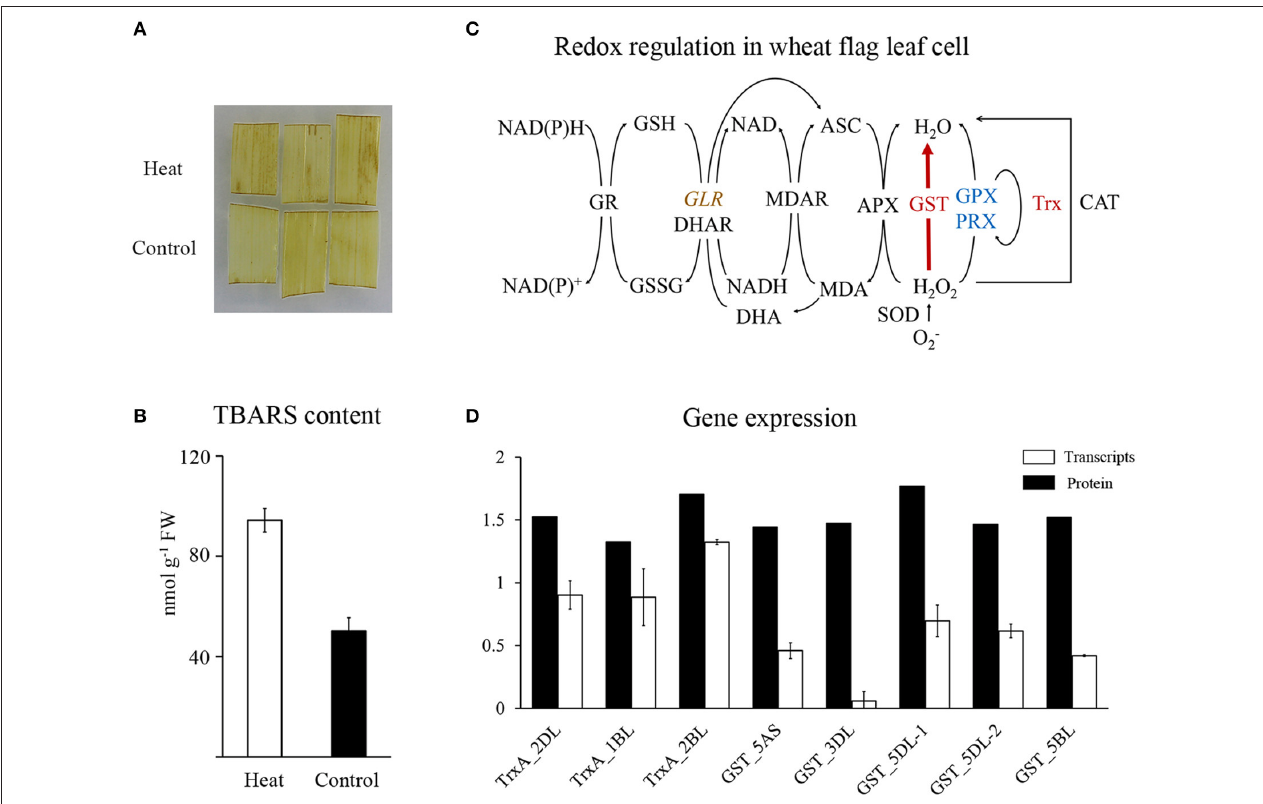
FIGURE 4 | Redox regulation in wheat flag leaf in heat condition. (A) DAB staining of wheat flag leaves. (B) TBARS content of wheat flag leaves. (C) Schematic representation of redox regulation. Red represent increased, blue represent decreased, brown with italic represent differentially regulated. Map was drawn based on Mittler et al. (2004). APX, Ascorbate peroxidase; ASC, Ascorbate; CAT, Catalase; DHA, Dehydroascorbate; DHAR, Dehydroascorbate reductase; GLR, Glutaredoxin; GPX, Glutathione peroxidase; GR, Glutathione reductase; GSSG, glutathione disulphide; GST, Glutathione S-transferase; MDAR, Monodehydroascorbate